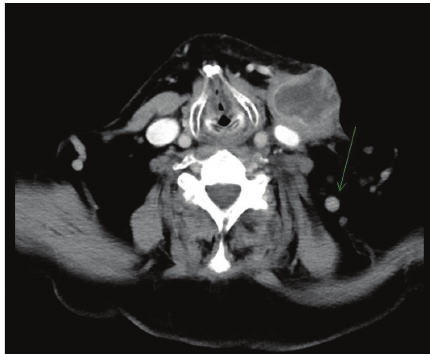
Figure 7: CT scan 6 months post-op, showing haemorrhagic node and level V lymphadenopathy